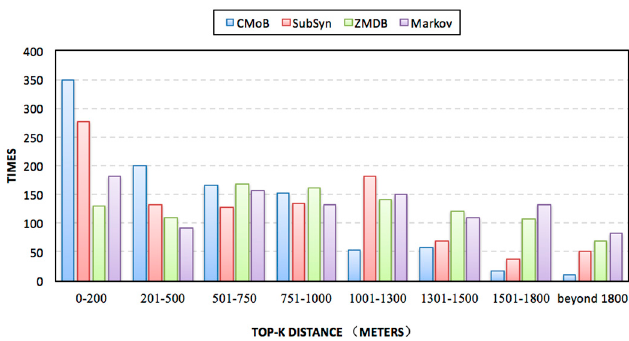
Figure 11. Top- k Error Histogram.